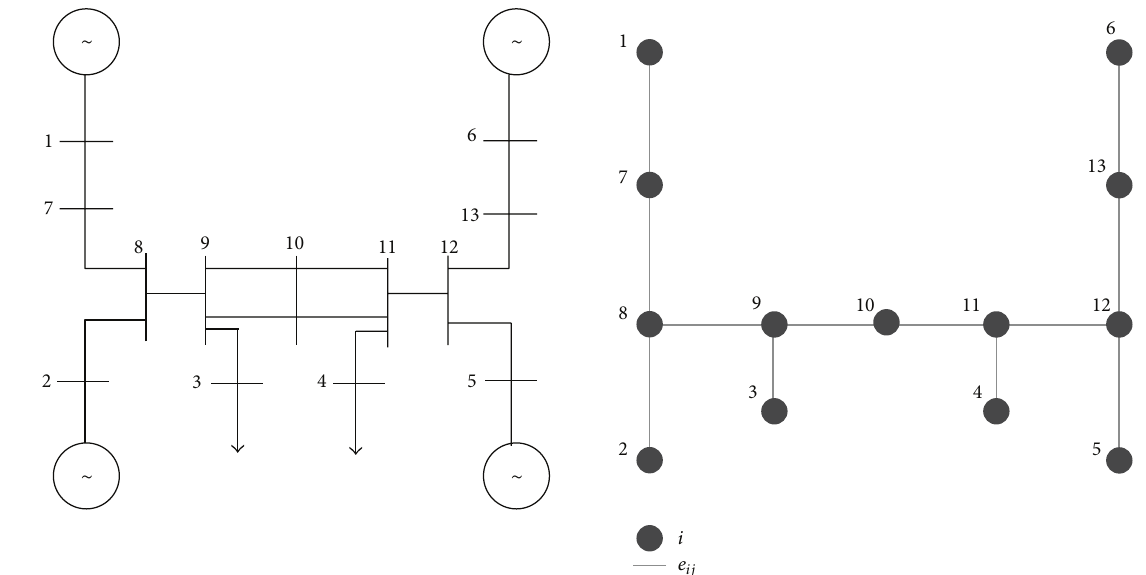
Figure 1: A power system and its correspondent